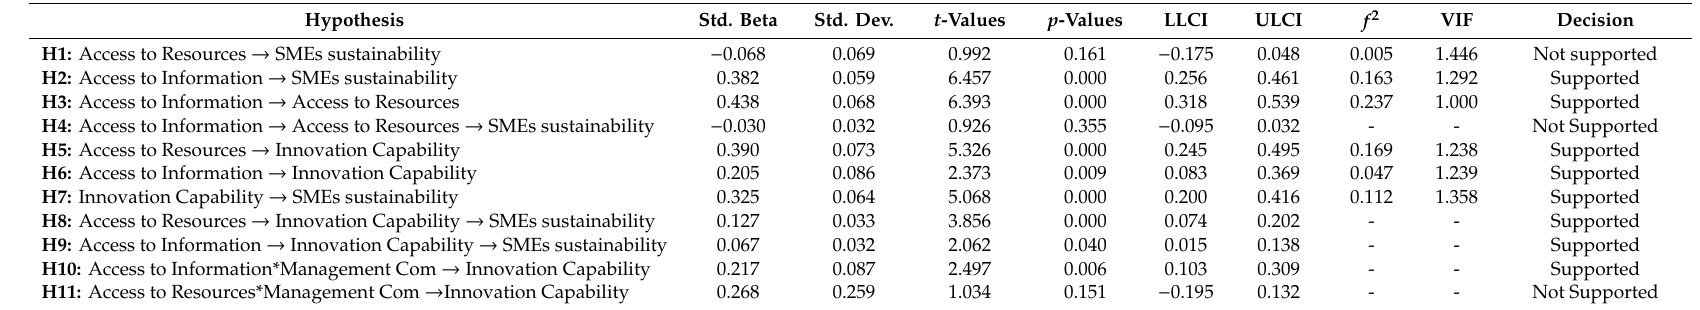
Table 4. Hypothesis